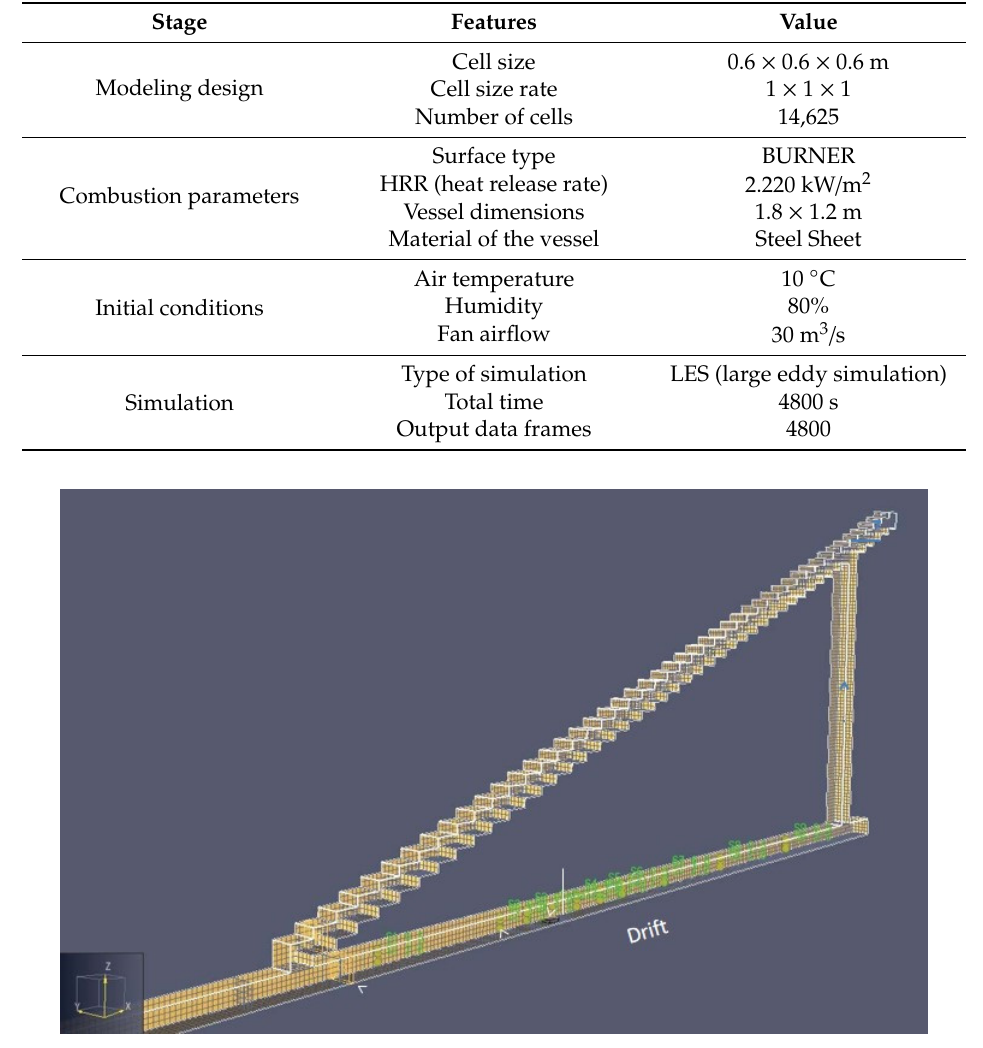
Figure 4. XYZ meshing of the drift.